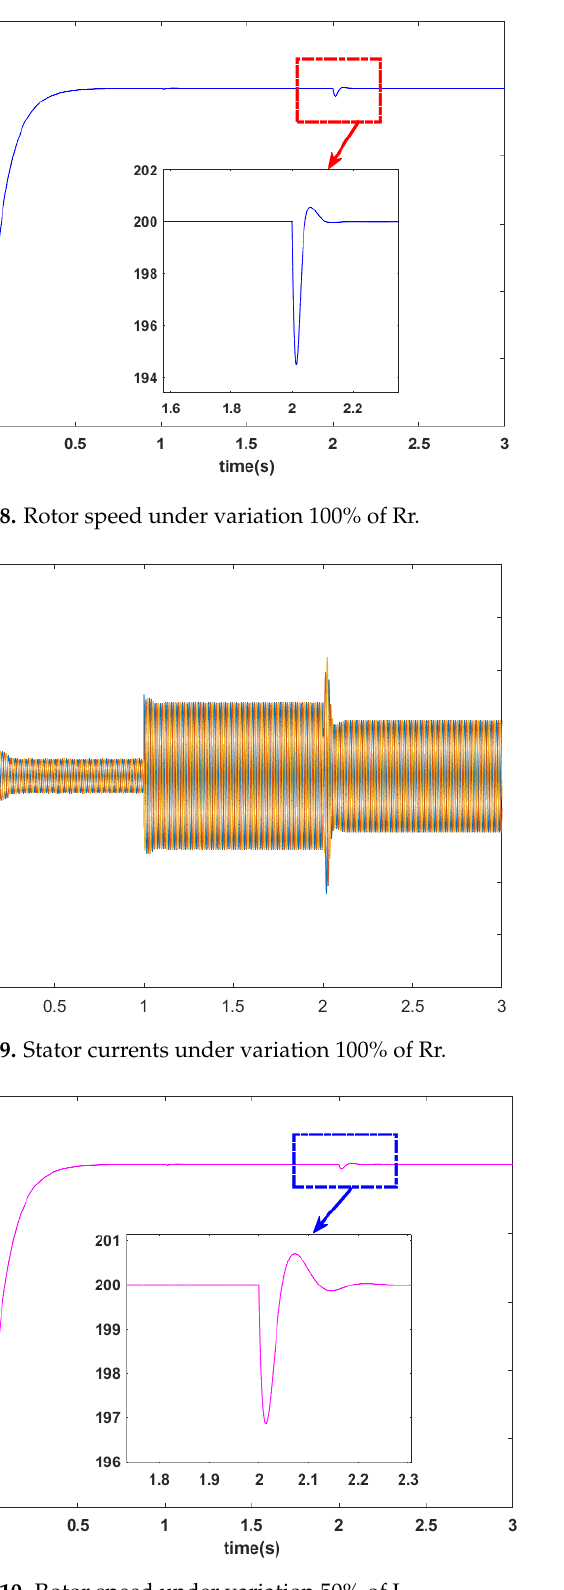
Figure 10. Rotor speed under variation 50% of